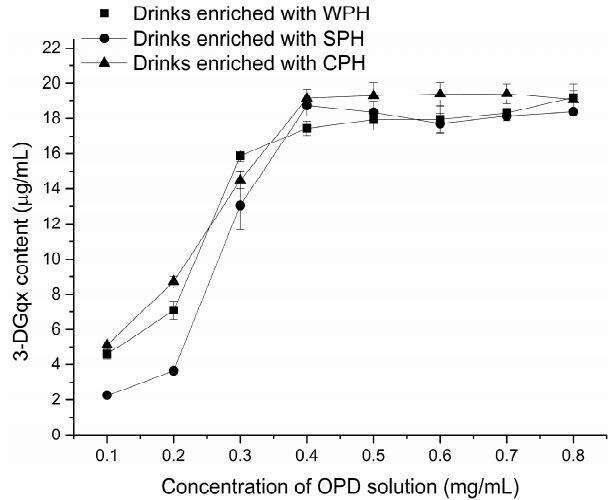
Figure 3. Effect of addition amount of o -phenylenediamine (OPD) on measured 3-DG quinoxaline (3-DG qx ) content in Peptide-enriched drinks (PEDs). Table 1. Repeatability and recovery rates of different concentrations of pyrraline and 3-DG.